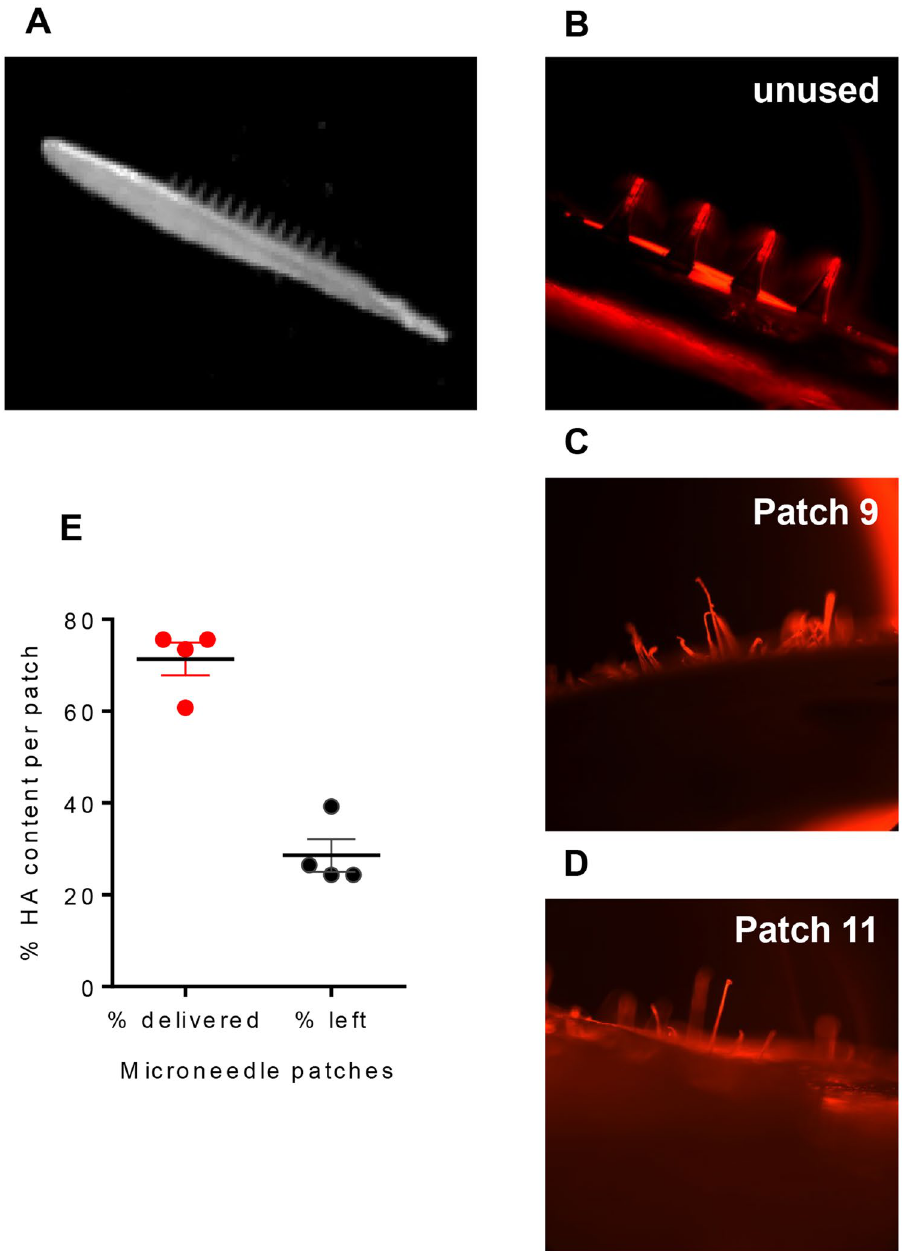
Figure 1. Encapsulation and Delivery of influenza vaccine using dissolving MN patches. ( A ) Microneedles were loaded with high dose of A/Brisbane/59/07 subunit vaccine (15 μ g). The patches were sealed with desiccant and kept @ + 4 °C. After being brought to the room temperature and unsealed, MN retained their structure and rigidity. ( B ) Unused MN patches were imaged with inverted microscopy (20x magnification). ( C,D ) Used MN patches 10 minutes after insertion into murine skin (20x magnification, inverted microscopy). Some stretched out protrusions can be seen in the used patches possibly containing undelivered vaccine. ( E ) Percent residual A/Brisbane/59/07 vaccine per patch after insertion into murine skin. The vaccine content after loading and after insertion was determined by SRID. The vaccine was extracted from the patches in the same volume of PBS and run in triplicates. SRID standards ranged from 10 to 70 μ g/ml HA. The values were expressed as mean ±